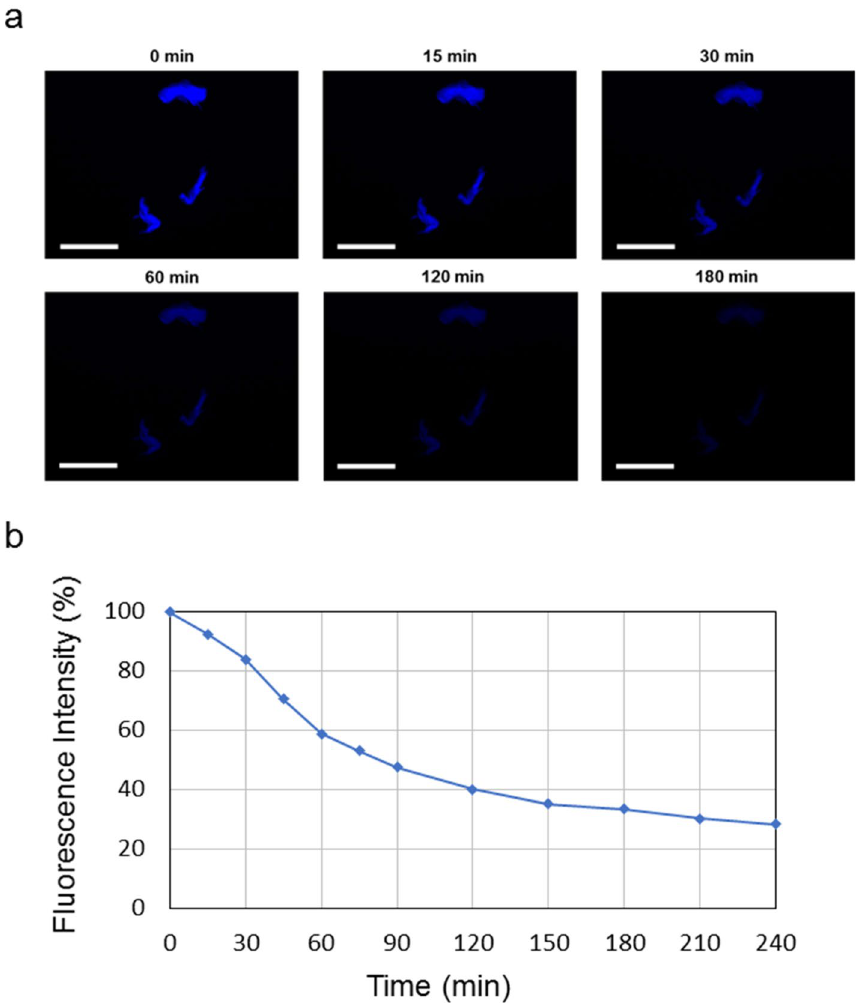
Figure 7. ( a ) Selected fluorescence microscopy images of the peptide solution drop-casted on a glass slide and air-dried at room temperature. Images are obtained by exciting the sample in the spectral region of DAPI and keeping the light on for 240 min. Scale bar is 50 μm. ( b ) Evaluation of the fluorescence intensity percentage decrease due to photoinstability